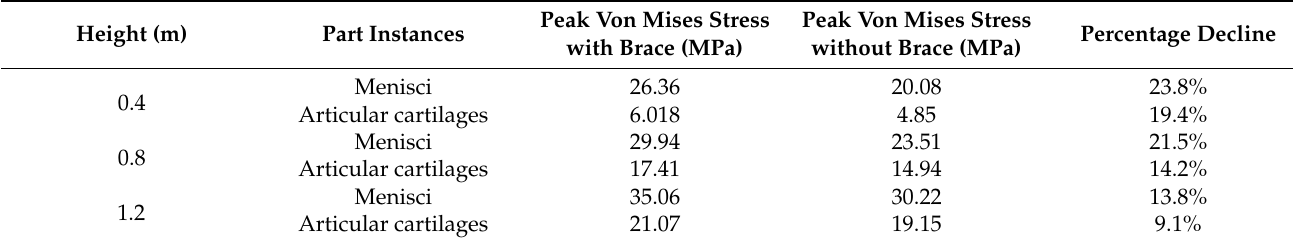
Table 2. The peak von Mises stress of the menisci and articular cartilages with and without the brace at 0.4 m, 0.8 m, and 1.2 m.